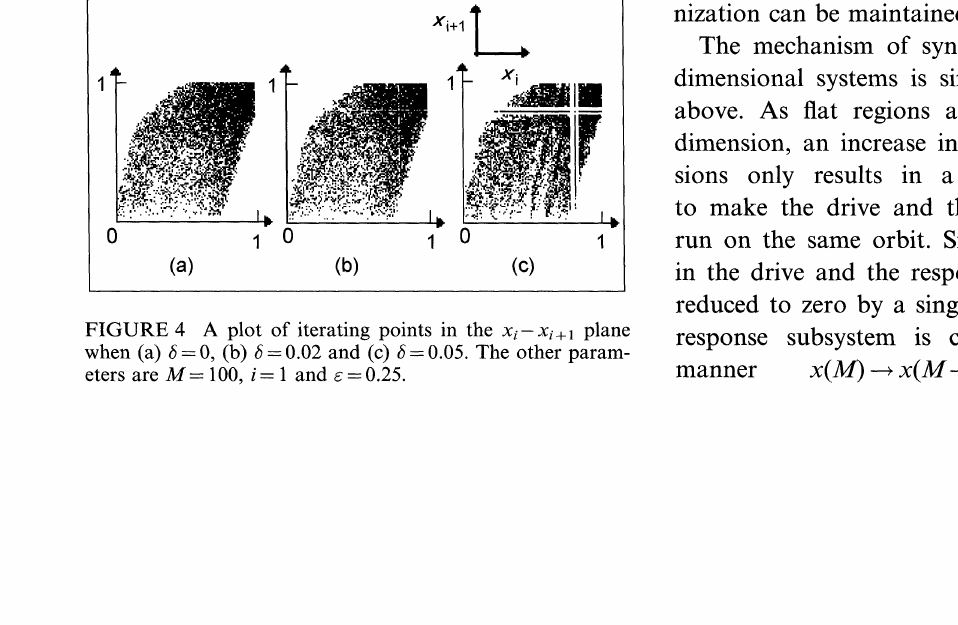
FIGURE 4 A plot of iterating points in the x when (a) 6--0, (b) 6 =0.02 and (c) 3 0.05. The other param- eters are M 100, and e 0.25.